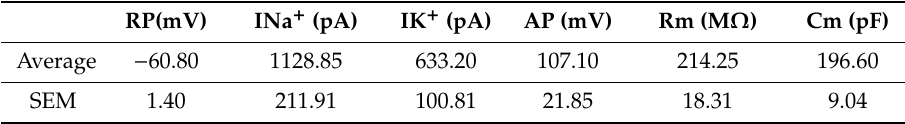
Table 1. Quantification of the electrophysiological parameters (N = 5 cells). RP: Resting membrane potential; INa + : Sodium current; IK + : Potassium current; AP: Action Potential; Rm: Membrane Resistance; Cm: Membrane